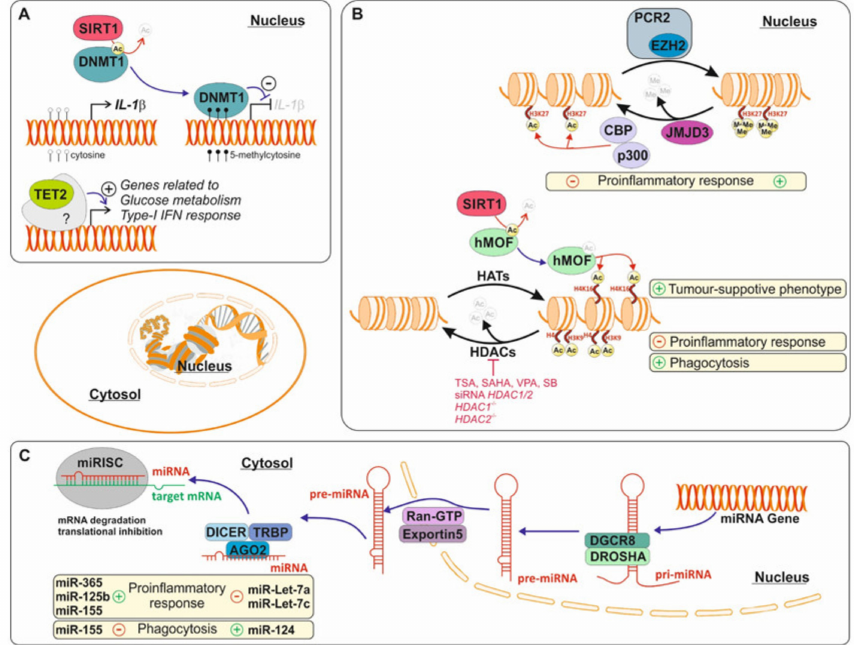
Figure 2. Schematic representation of epigenetic control of the inflammatory response in microglia. ( A ) SIRT1 deacetylates and activates DNMT1, provoking IL-1 β repression through DNA